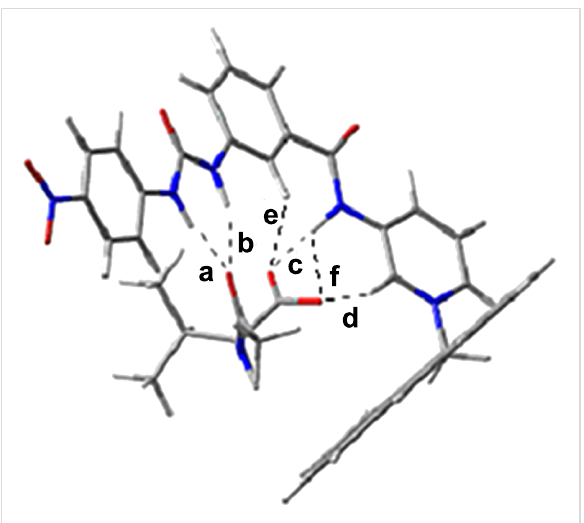
Figure 9: DFT optimized geometry of the complex of 1 with L- N- acetyl- valine carboxylate salt [a = 1.93 Å, b = 1.99 Å, c = 1.64 Å, d = 1.97 Å, e = 2.60 Å and f = 2.69